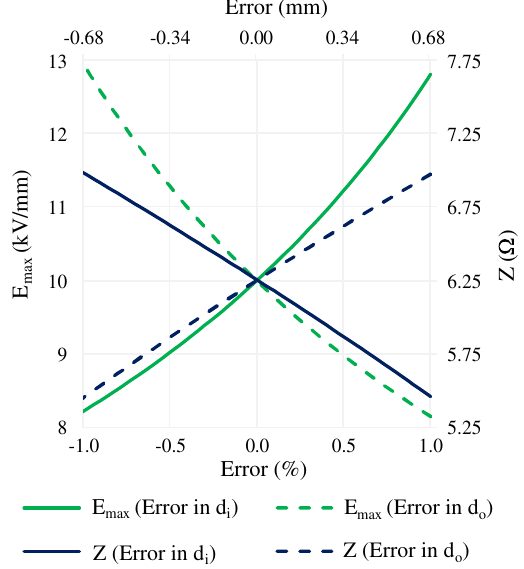
FIG. 4. Influence of a manufacturing error, in either the inner diameter of the primary winding or the outer diameter of the stalk, upon E and Z max